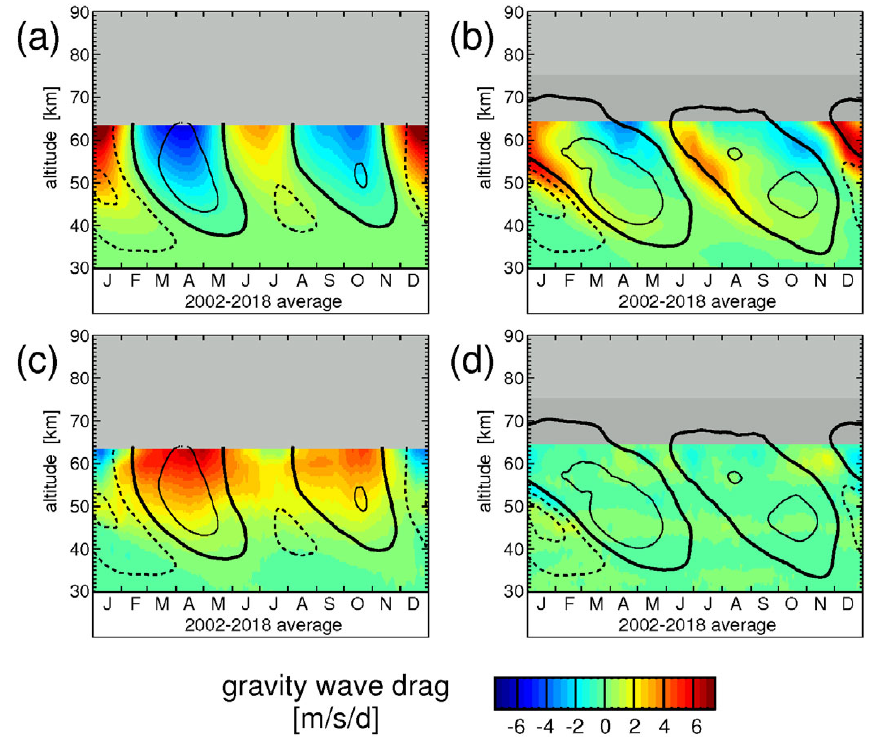
Figure 6. Typical seasonal variation of parameterized gravity wave drag X param for the reanalyses (a) JRA-55 and (b) MERRA-2, as well as the gravity wave drag term X imbalance for (c) JRA-55 and (d) MERRA-2. The term X imbalance includes, for example, the model imbalance that is caused by data assimilation. Again, values are averages over 10 ◦ S–10 ◦ N and the time period 2002–2018, and contour lines of the respective wind data set are overlaid. Contour line increment is 20ms − 1 . The zero wind line is highlighted in bold solid contour lines, and westward (eastward) winds are indicated by dashed (solid) contour